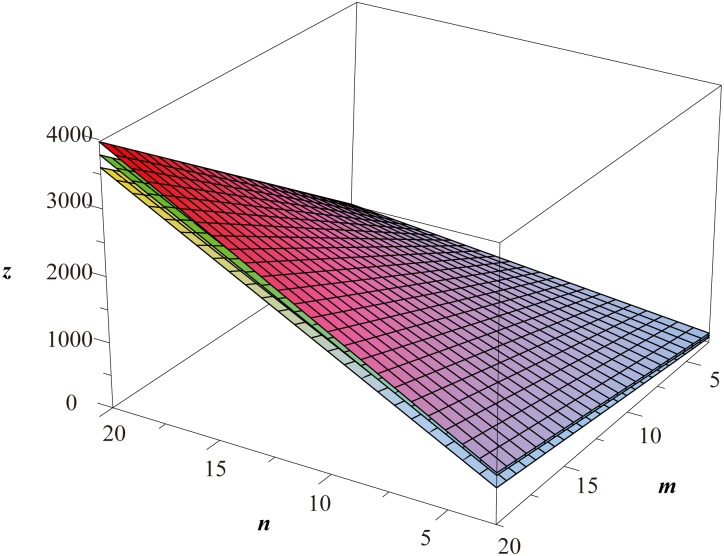
The Wiener polarity index of Ht(n, m), Hc(n, m) and Hf(n, m).